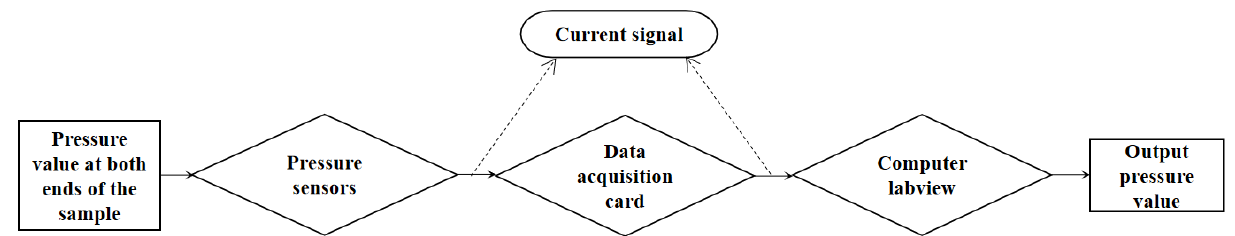
Figure 5. Schematic diagram of the pressure data acquisition .